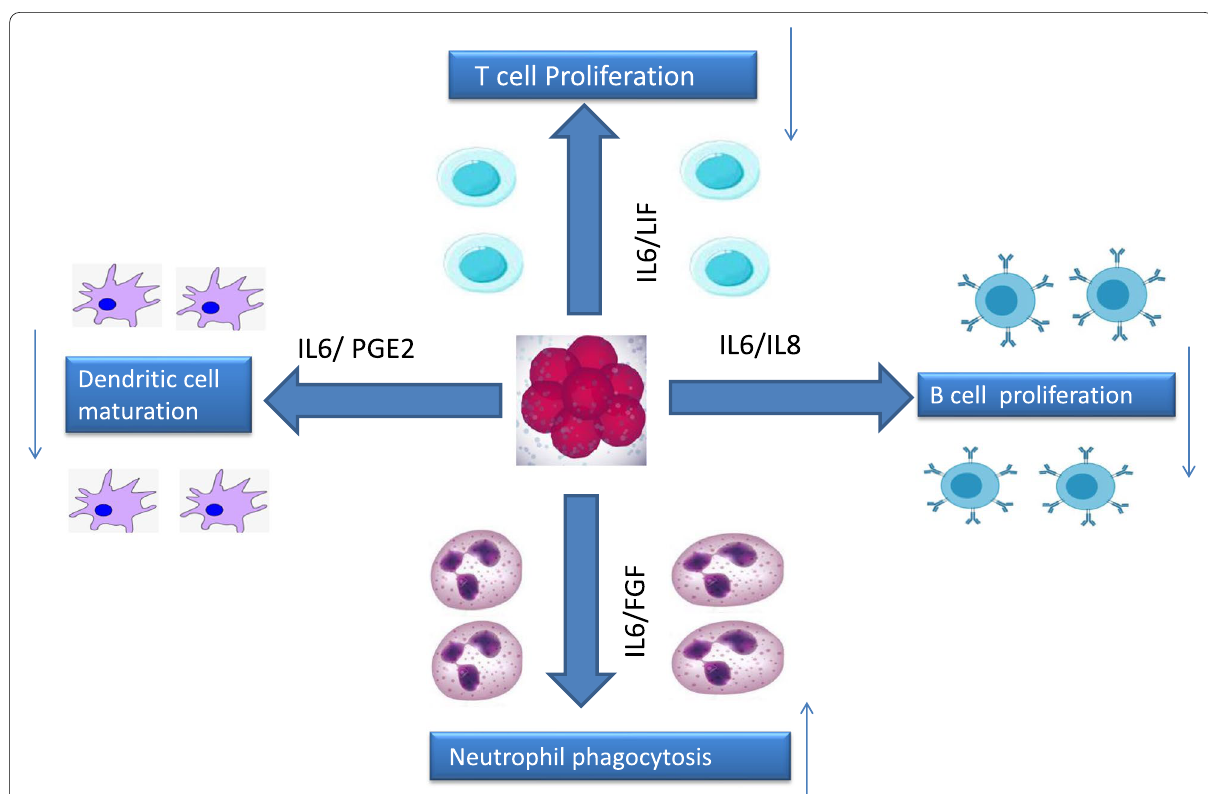
Fig. 4 Effect of Mesenchymal stem cells (MSCs) on dendritic cell, B cell, T cell and Neutrophil. Mesenchymal stem cells with the effect of interleukin 6,8, LIF and PGE2 reduce cell secretion and increase the activity of dendritic